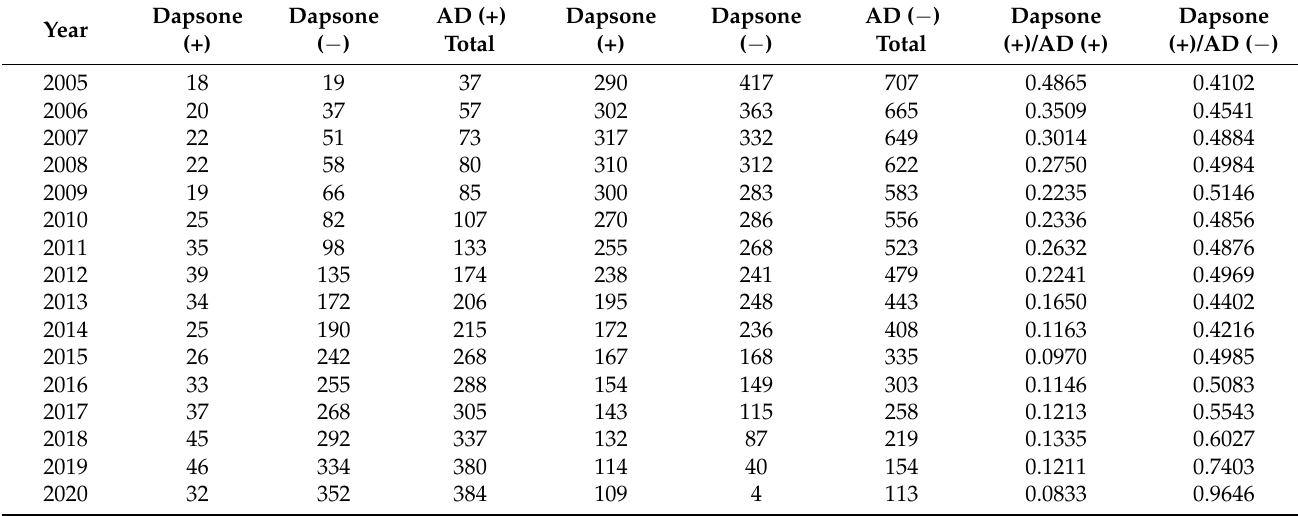
Table 2. AD prevalence (+/ − ) in the dapsone prescription (+)/non-prescription ( − ) group.